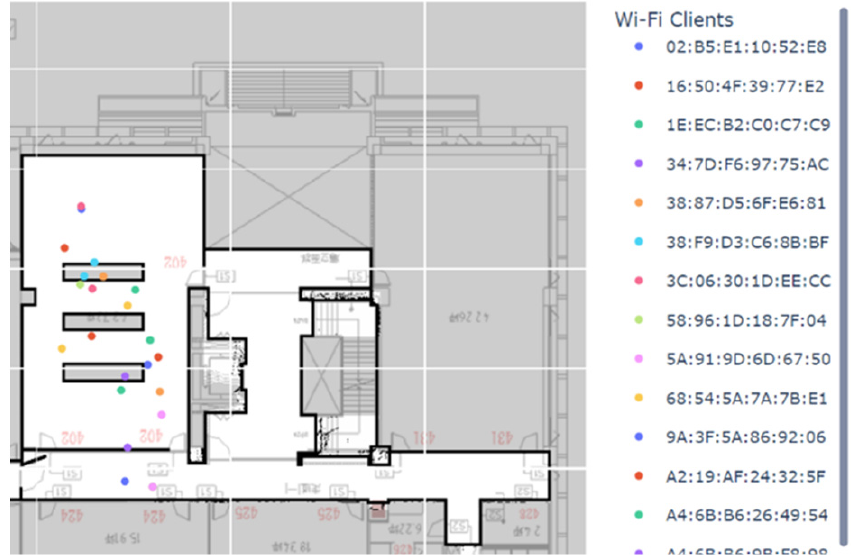
Figure 17. The screenshot of the Web plot of the online system.